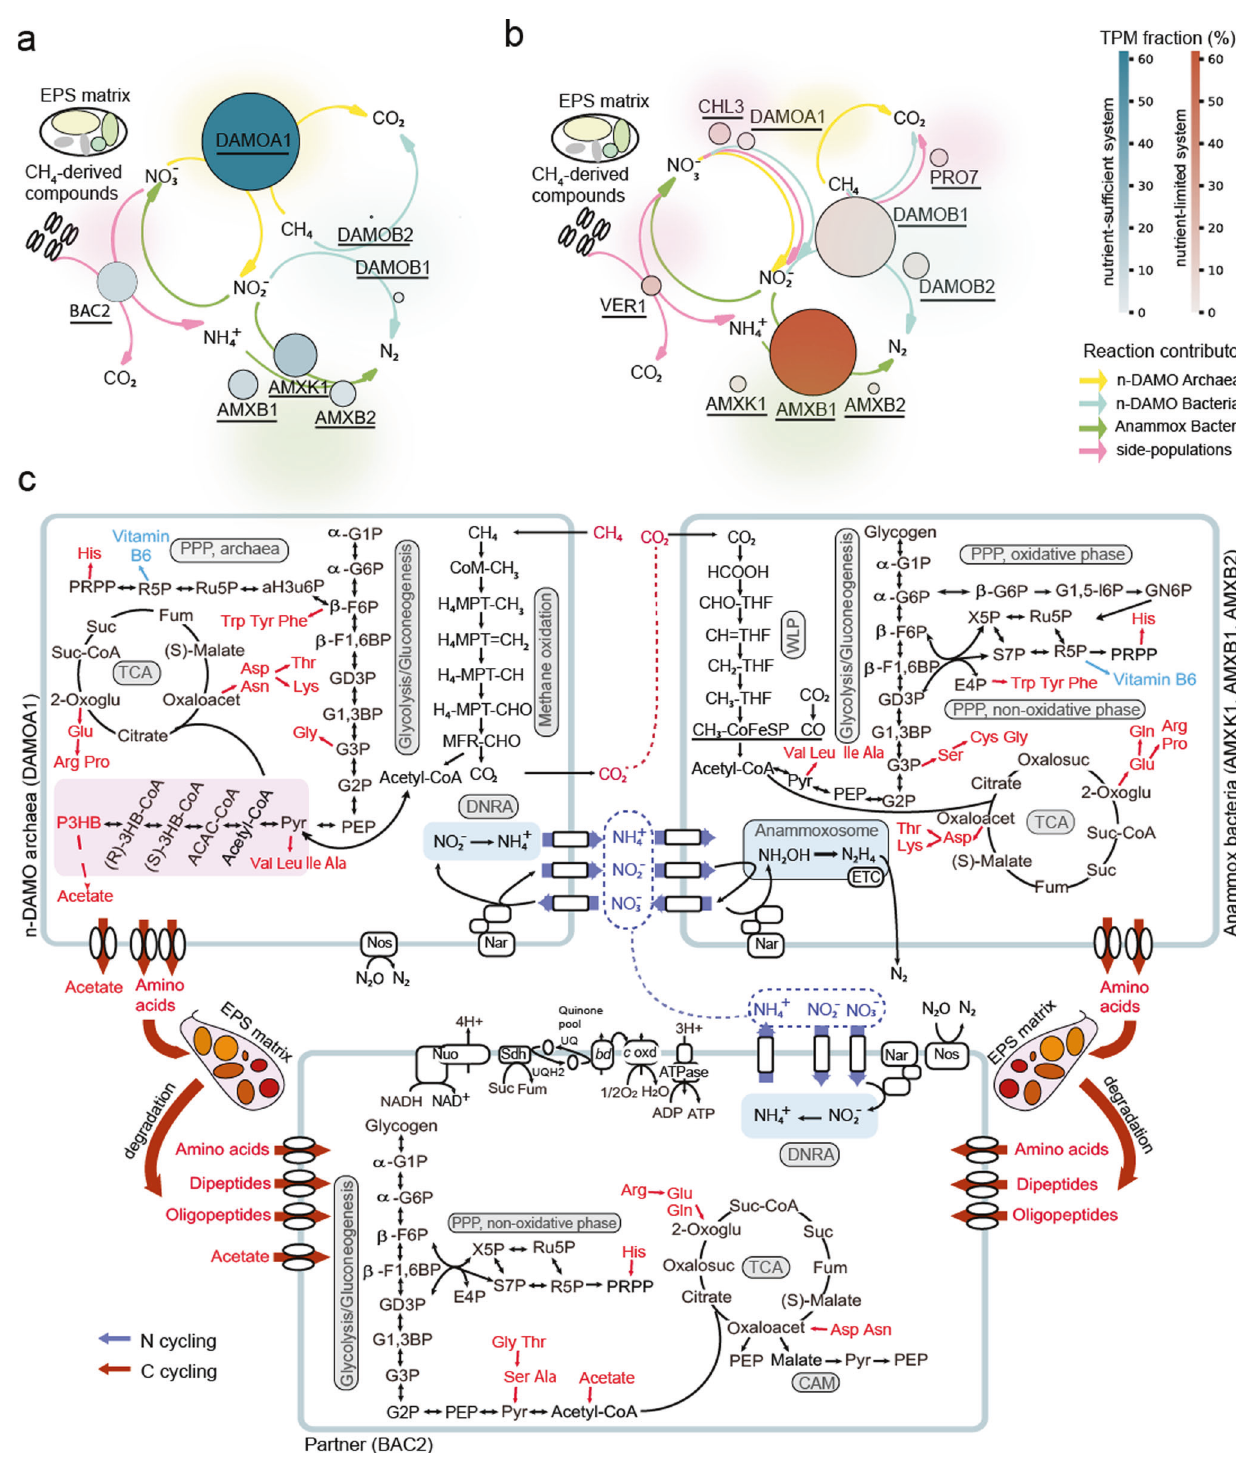
Fig. 5 Schematic of metabolic networks. a Schematic of microbiota metabolic network under high-loading and b low-loading conditions: bubble size indicates the relative abundance, while the colour intensity indicates the expression fraction. c Integrating metabolic network related to nitrogen and methane conversions in high-loading system High_BS: blue arrows indicate nitrogen cycling, while red arrows indicate carbon cycling.